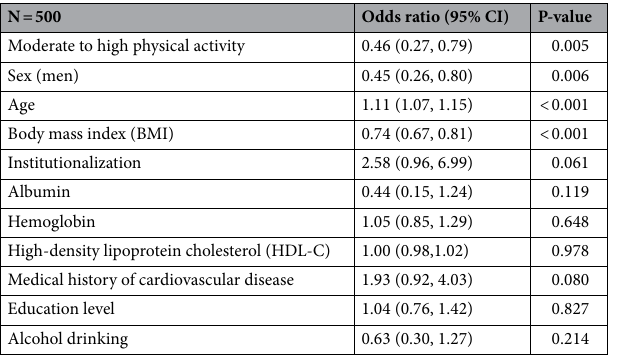
Table 3. Adjusted model for associated factors of sarcopenia in the study population according to the 2019 AWGS diagnostic criteria of sarcopenia.